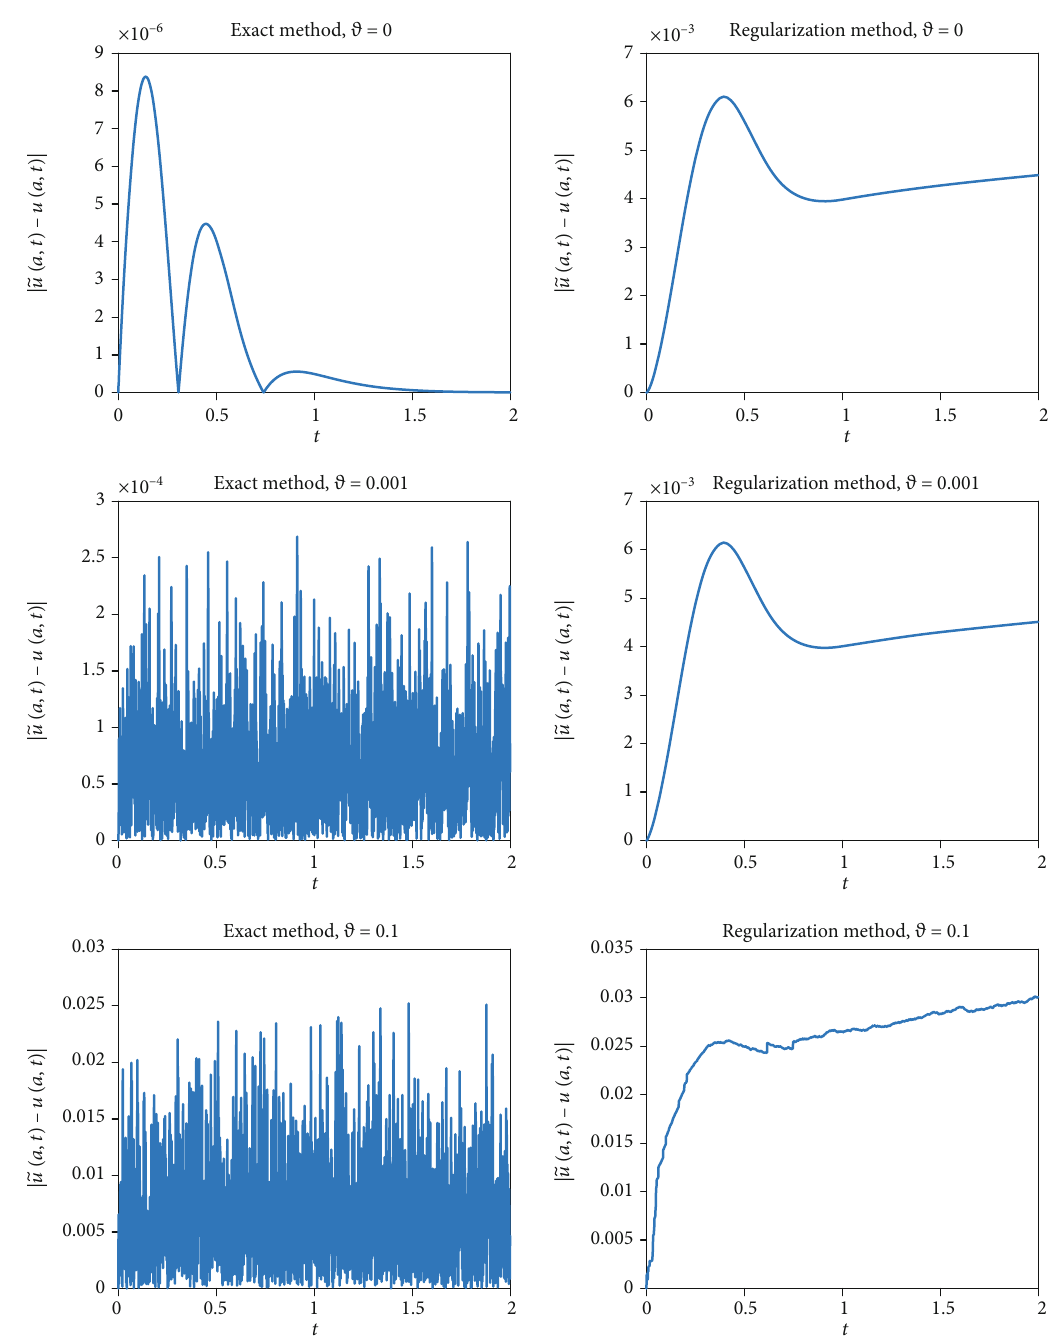
Figure 7: The absolute errors j ~ u ð a , t Þ − u ð a , t Þj , with the exact and regularization methods and di ff erent values of noises for Example 4 using Δ t = 0 : 001 and h = 0 : 05